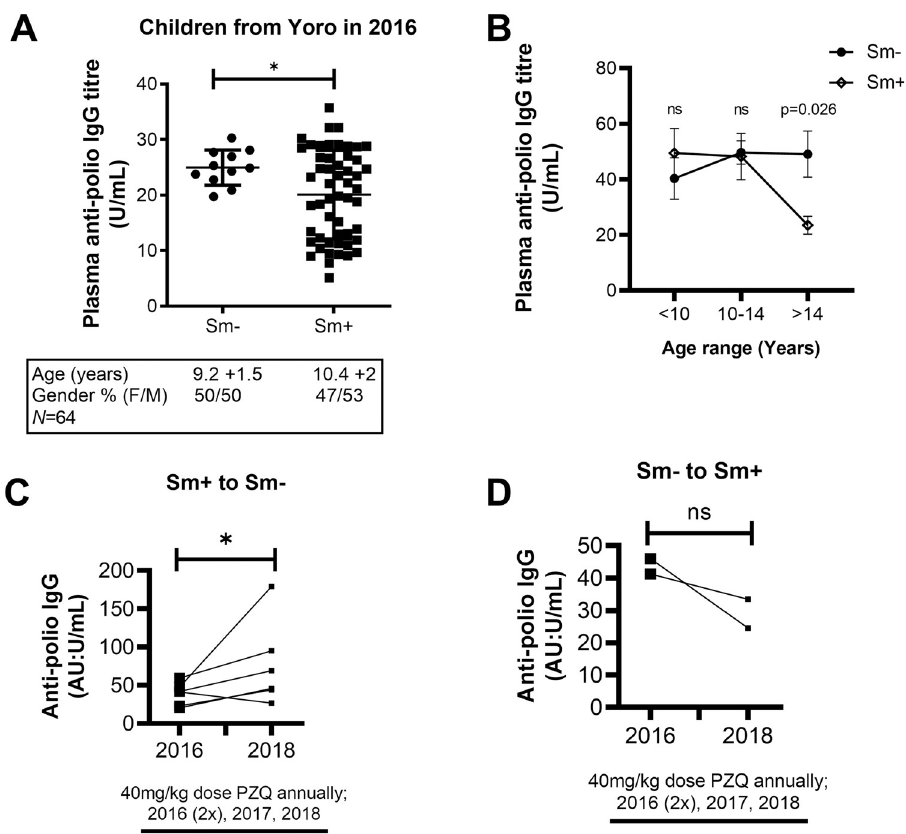
Fig 1. Influence of S. mansoni infection and age on vaccine-induced anti-poliovirus responses in school children from five schools in a rural region of Cameroon. (A) Anti-poliovirus IgG levels of a pilot group of school children in the village of Yoro, Bokito in Cameroon in the year 2016 (n = 64). A table indicating the population characteristics is shown below the graph. (B) Anti-poliovirus IgG titre distribution by S . mansoni prevalence and age groups in all children from the five additionally surveyed schools (n = 189). (C) Effect of Schistosomiasis infection, and its treatment with PZQ, on vaccine-induced plasma anti-poliovirus IgG titres in children going from egg-positive to egg-negative for S . mansoni over the 3 years (2016–2018) period (n = 6). (D). Effect of Schistosomiasis infection, and its treatment with PZQ, on vaccine-induced plasma anti-poliovirus IgG titres in children going from egg-negative to egg-positive for S . mansoni over the 3 years (2016–2018) period (n = 2). Data are expressed as mean ± S.D; All data were analysed by Shapiro-Wilk test followed by the two-tailed unpaired Student t test for unequal variances (A, B) and the two-tailed Wilcoxon signed-rank test or paired t test (C,D); ns, p > 0.05; � p < 0.05, �� p < 0.001, ��� p < 0.0001; Sm, S . mansoni ; PZQ,